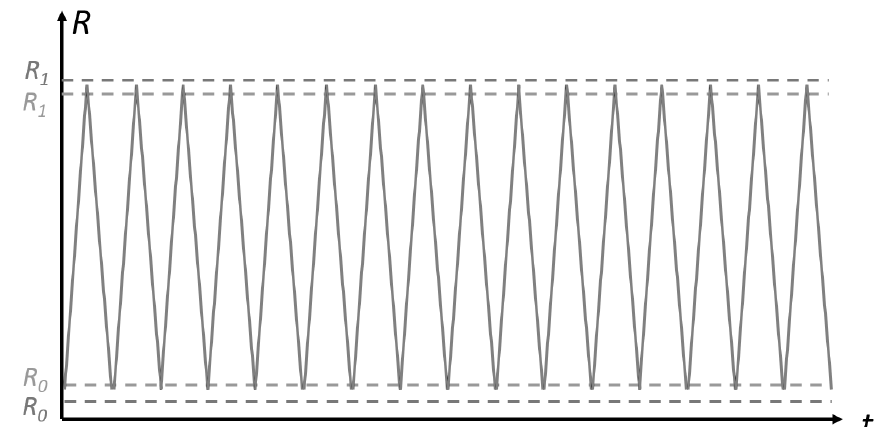
Figure 12. Momentum wheel (MW) rotation rate.